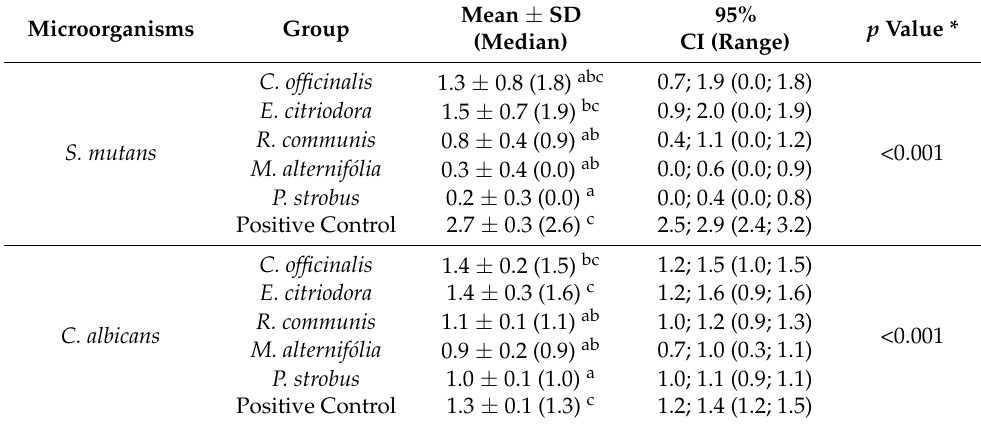
Table 3. Descriptive statistics of inhibition halo (mm) for S. mutans and C. albicans and statistical